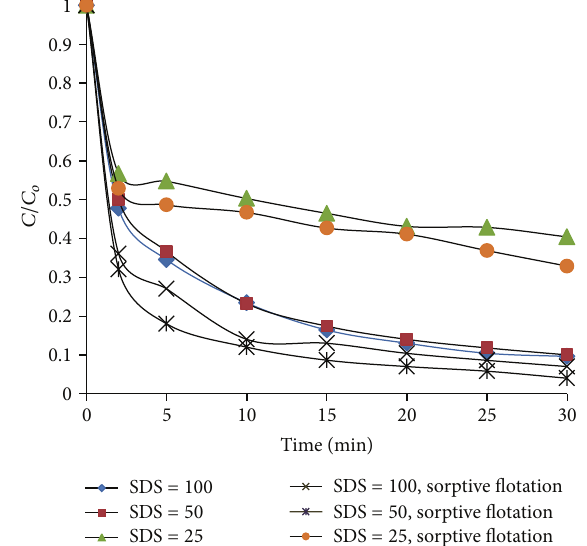
Figure 3: Effect of pH on the removal of lead ions ( 𝐶 𝑜 = 50 mg/L; SDS = 25 mg/L; 𝑄 = 500 mL/min; barley husks = 20gm/L).